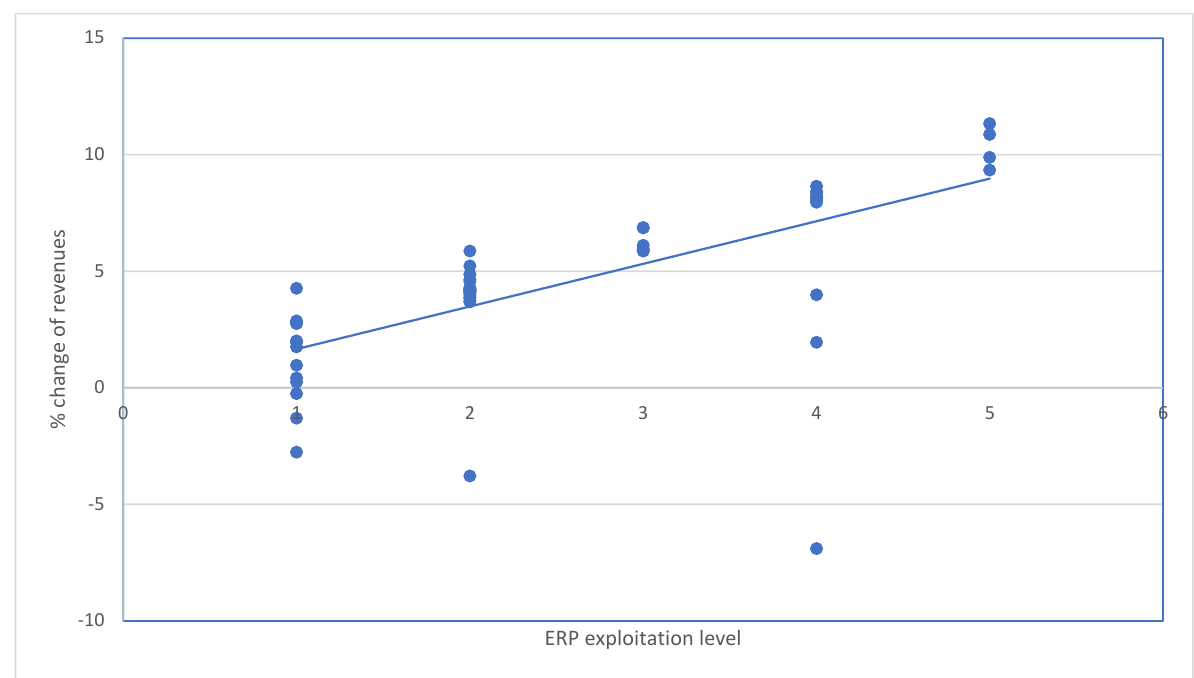
Figure 9. Correlation between the examined variables (ERP exploitation level and percentage change in revenues).